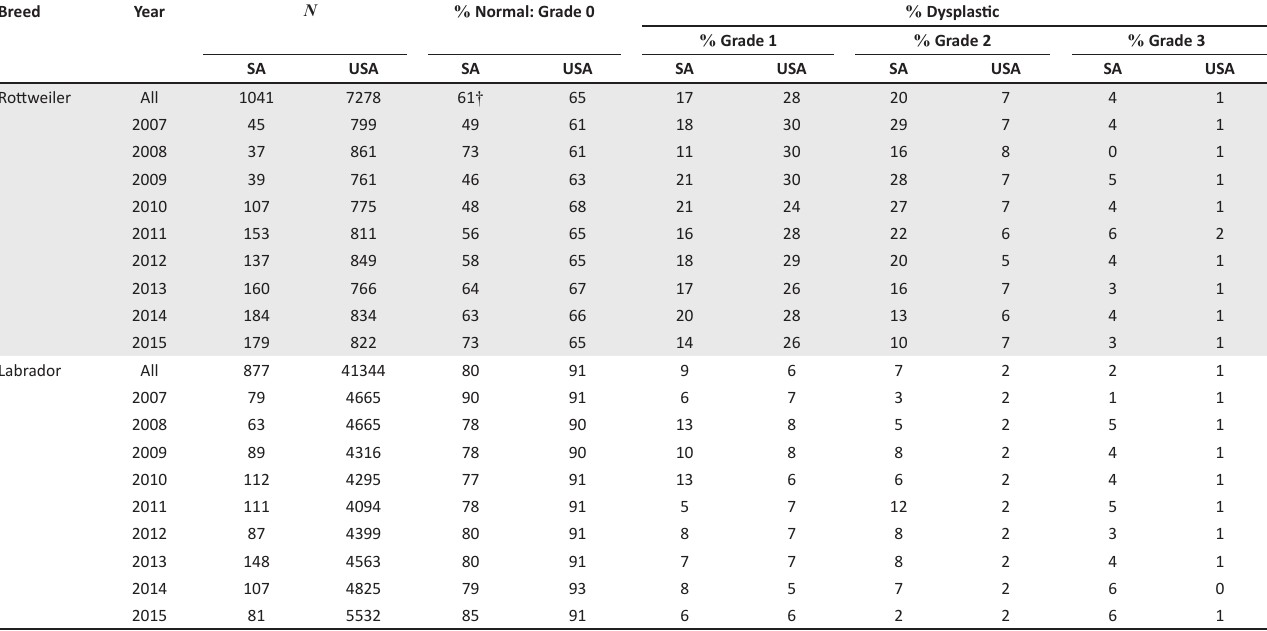
TABLE 4: Grade incidence of dogs affected by elbow dysplasia (Grades 1–3) in South Africa with data compared to that of the Orthopaedic Foundation of America from 2007 to 2015.